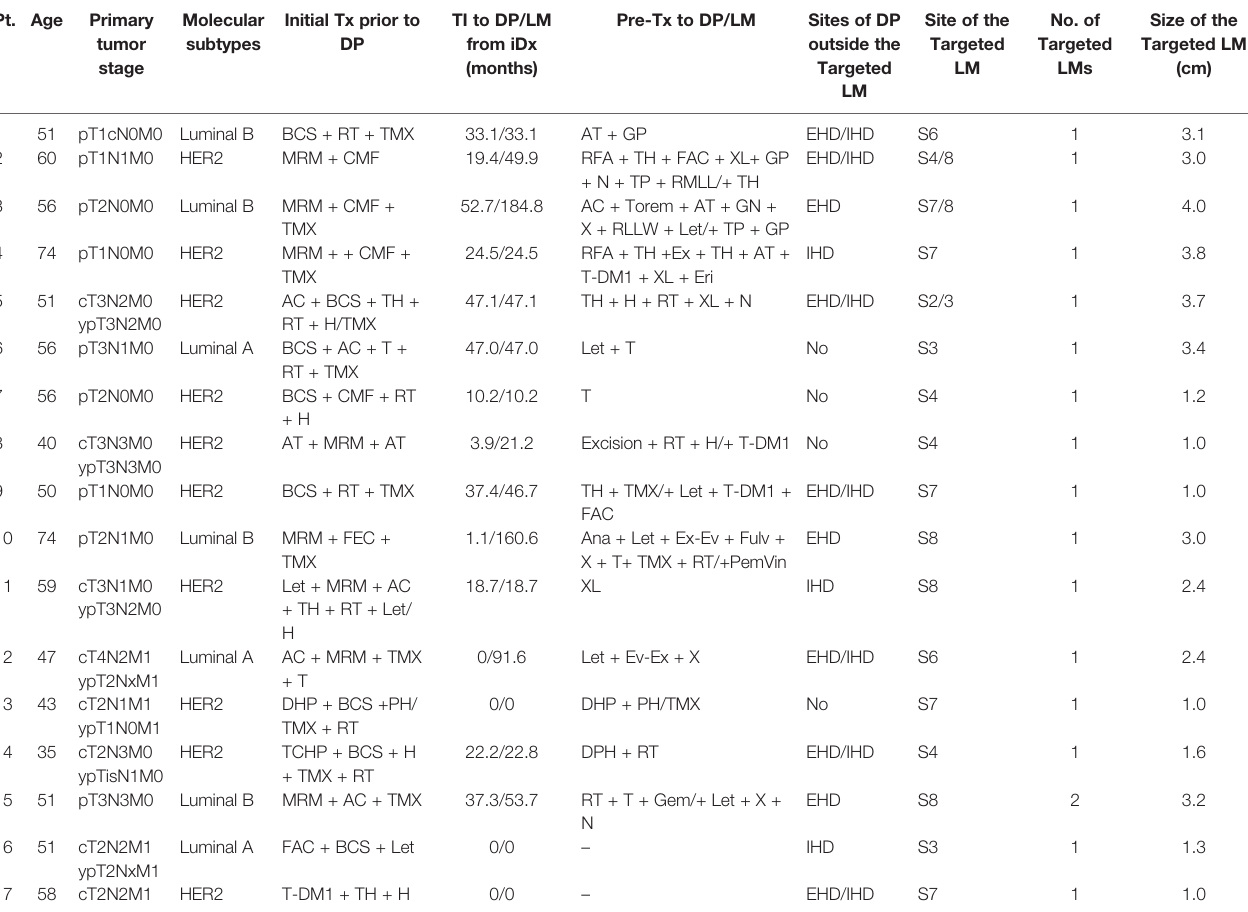
TABLE 1 | Patient